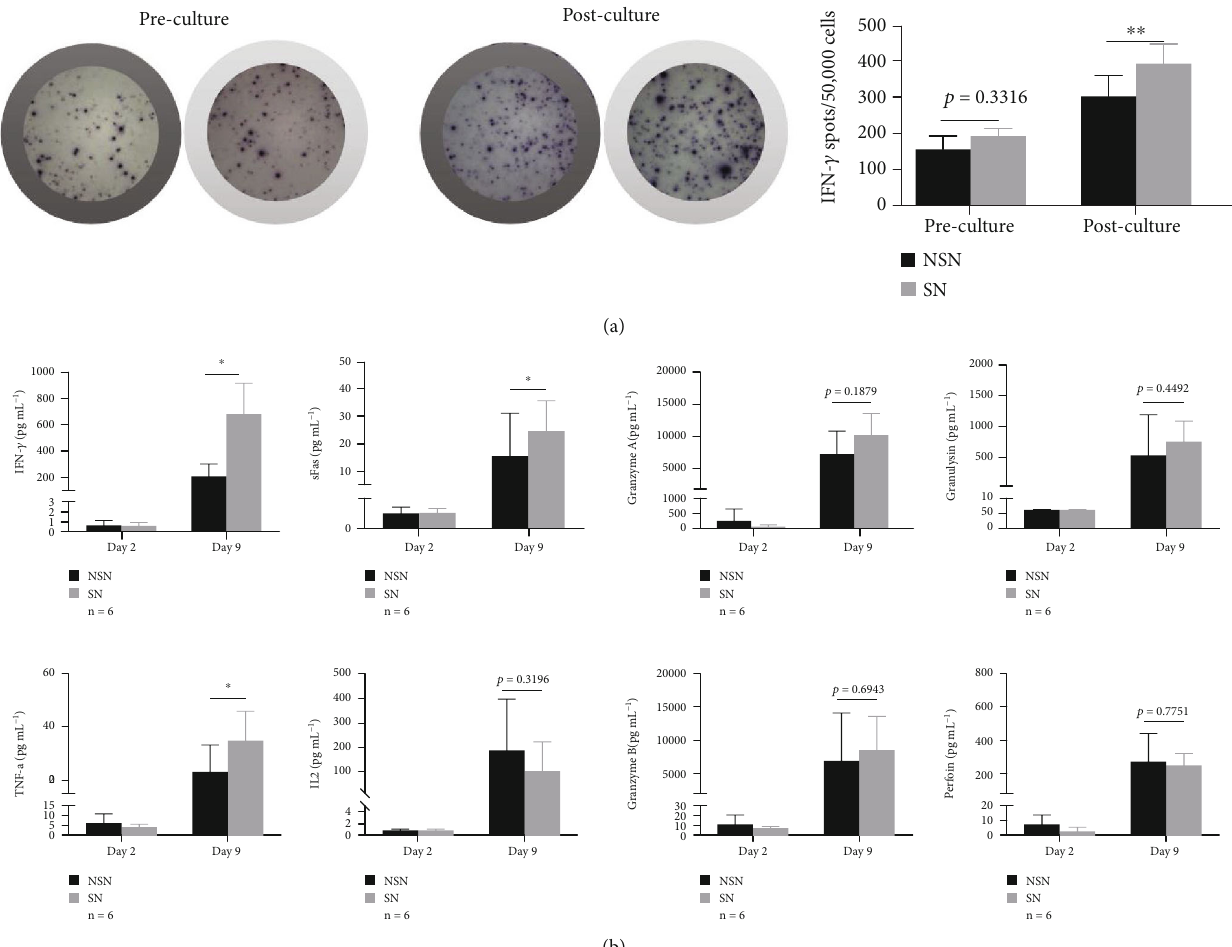
Figure 8: Cytokine changes induced by ex vivo culture. (a) ELISpot assay was performed to detect IFN- γ secretion stimulated by autologous tumor antigen. (b) Production of IFN- γ , IFN- α , sFas, IL-2, granzyme A, granzyme B, granulysin, and perforin on the second and ninth days of ex vivo culture was measured by using LEGENDplex. ∗ p < 0 : 05